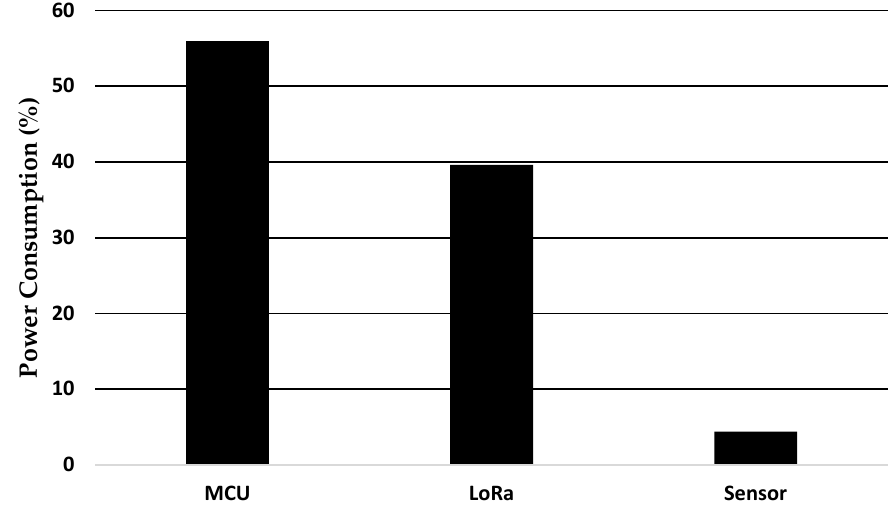
Figure 22. The power consumption percentage of the WSTx elements.